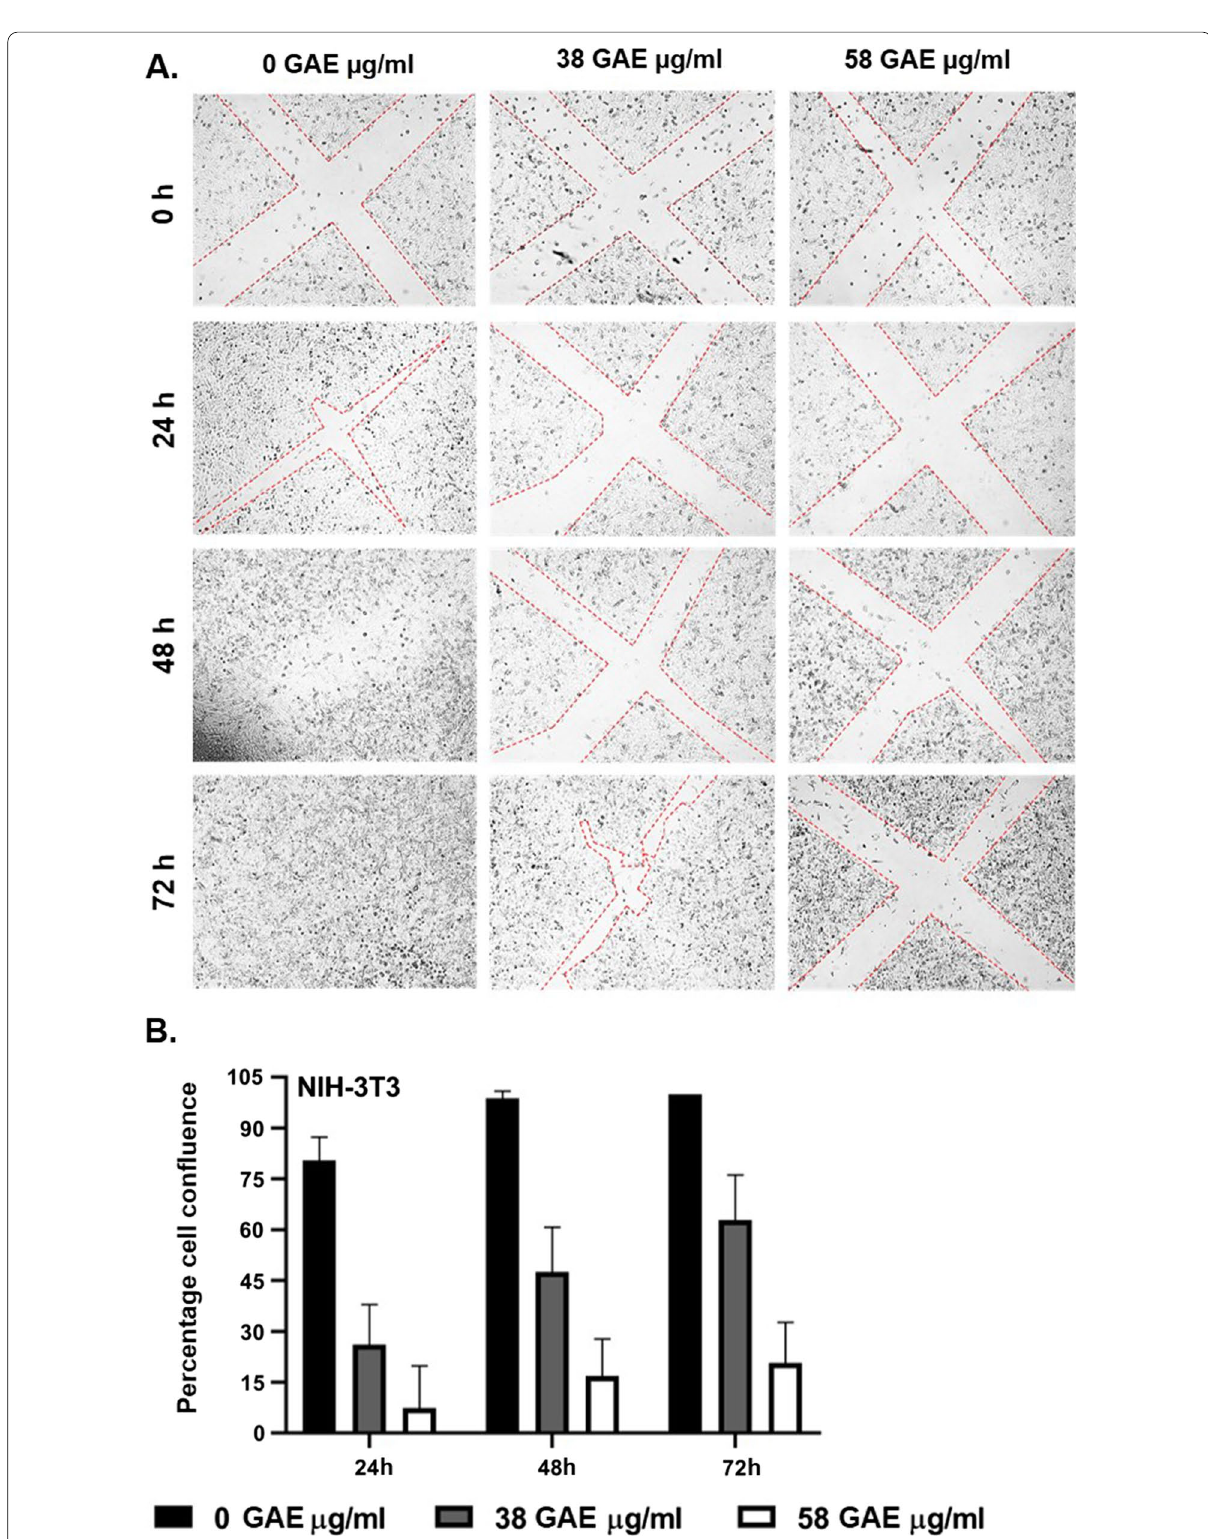
Fig. 4 Scratch Wound Healing assay on scraped NIH‑3T3 (murine skin fibroblasts) monolayers treated with non‑cytotoxic whole apple ( Malus domestica var. Anna) extract concentrations (38 and 58 µg GAE ml − 1 ) for 72 h. A . Representative photograph (10x) of the lesions over time. B . Percentage (mean SD, n 3) cell confluence in the lesion over time (Graph‑Pad Prism v. ± =